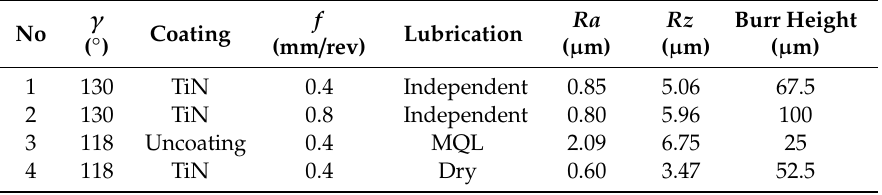
Table 7. Selection of the best tools and parameter for di ff erent